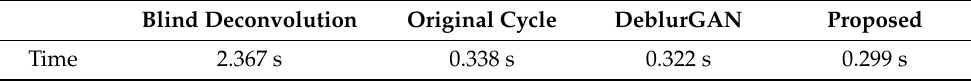
Table 4. Comparison of processing time of different deblurring